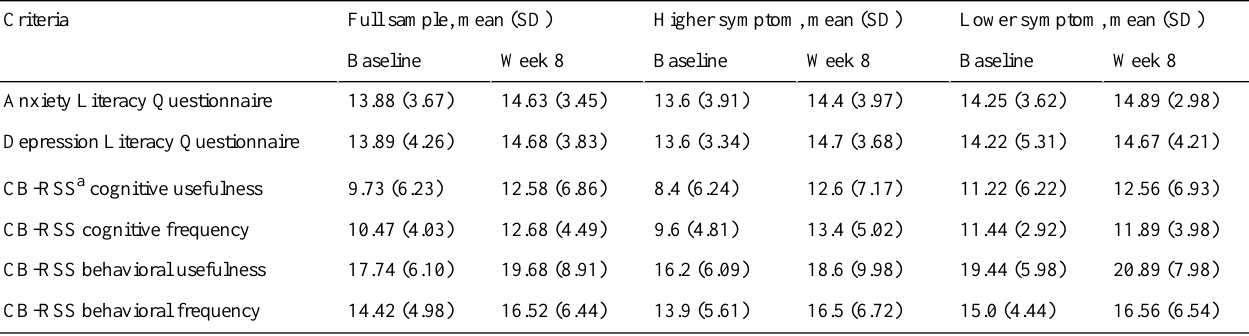
Table 1. Descriptive statistics of psychosocial targets for the full sample and by subgroup.